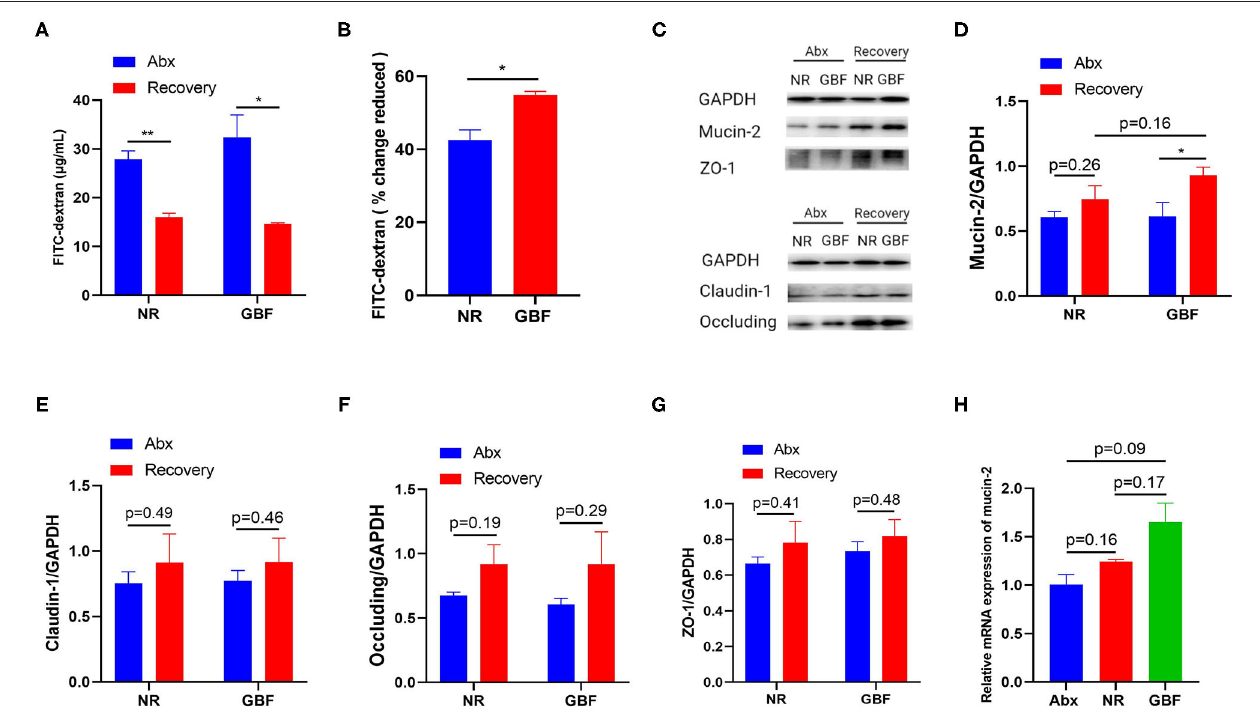
FIGURE 3 | GBF treatment improved the integrity of the intestinal barrier in the colon. (A) Intestinal permeability was measured in vivo with the FITC-dextran method. (B) Reduced intestinal permeability between the NR and GBF groups was normalized and compared. (C) Representative images of the expression of mucin-2 and tight-junction proteins with western blot analysis. (D–G) The statistical analysis of the expression of mucin-2 and tight junction proteins. (H) The relative quantity of mucin-2 messenger RNA (mRNA) was measured with quantitative PCR (qPCR). Significance was determined using the two-tailed unpaired t -tests. The values are expressed as the means ± SEM., n = 6 per group. * P < 0.05, ** P <